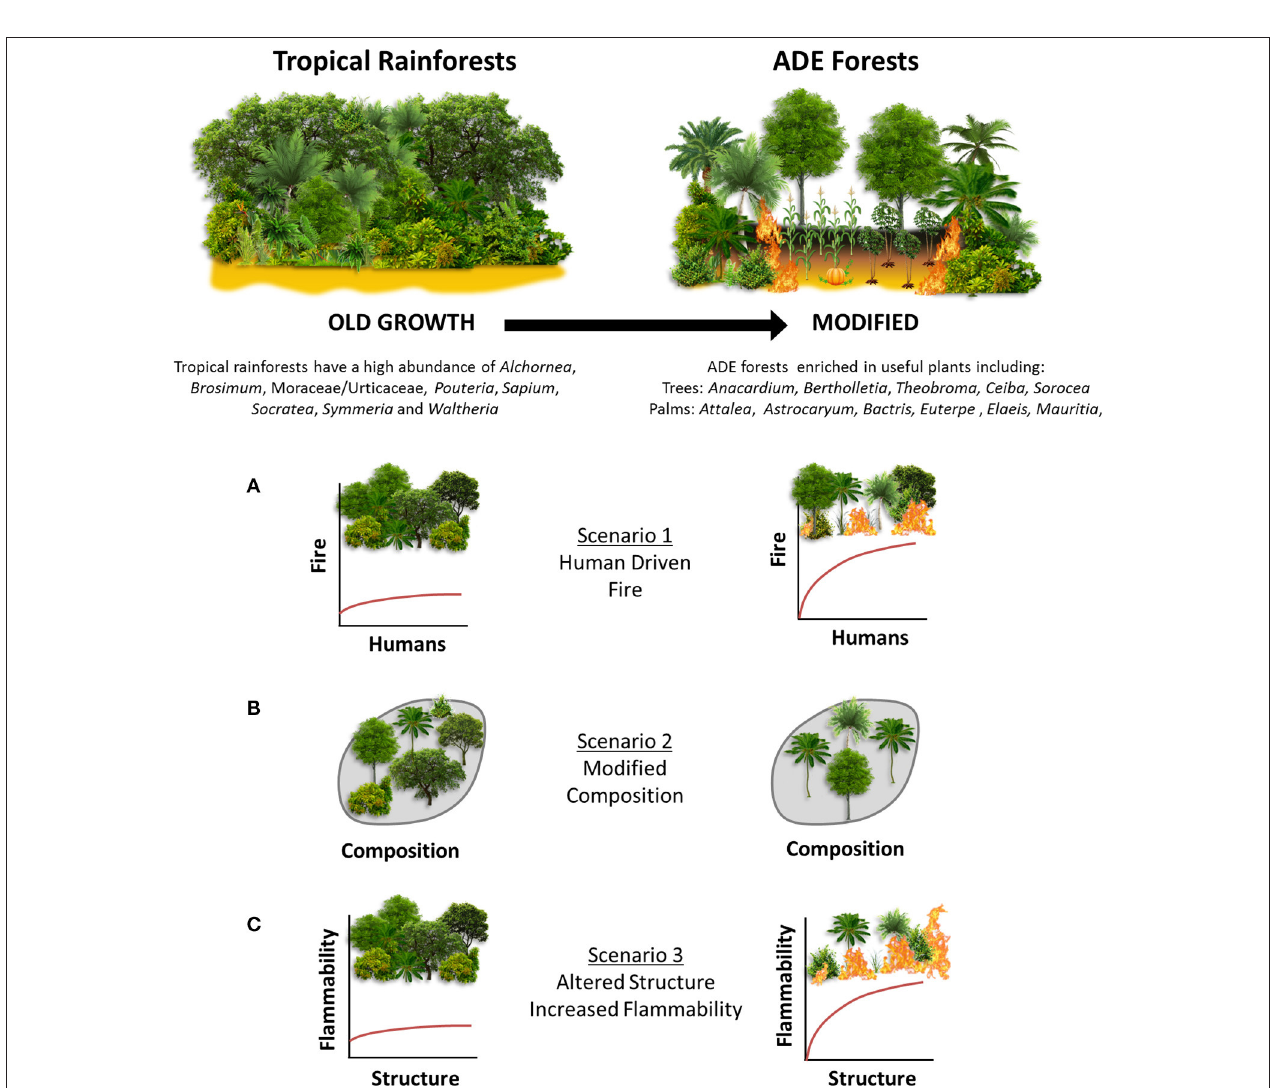
FIGURE 1 | Conceptual framework of old growth vs. ADE forests. (A–C) indicate research scenarios examined in this